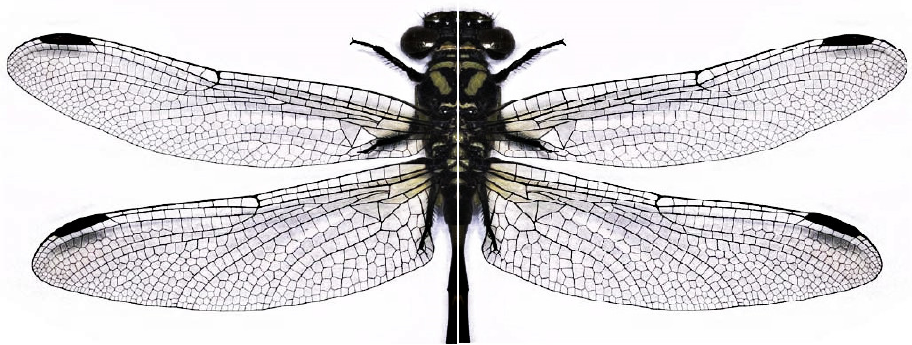
Figure 1. Dragonfly wing sample picture.